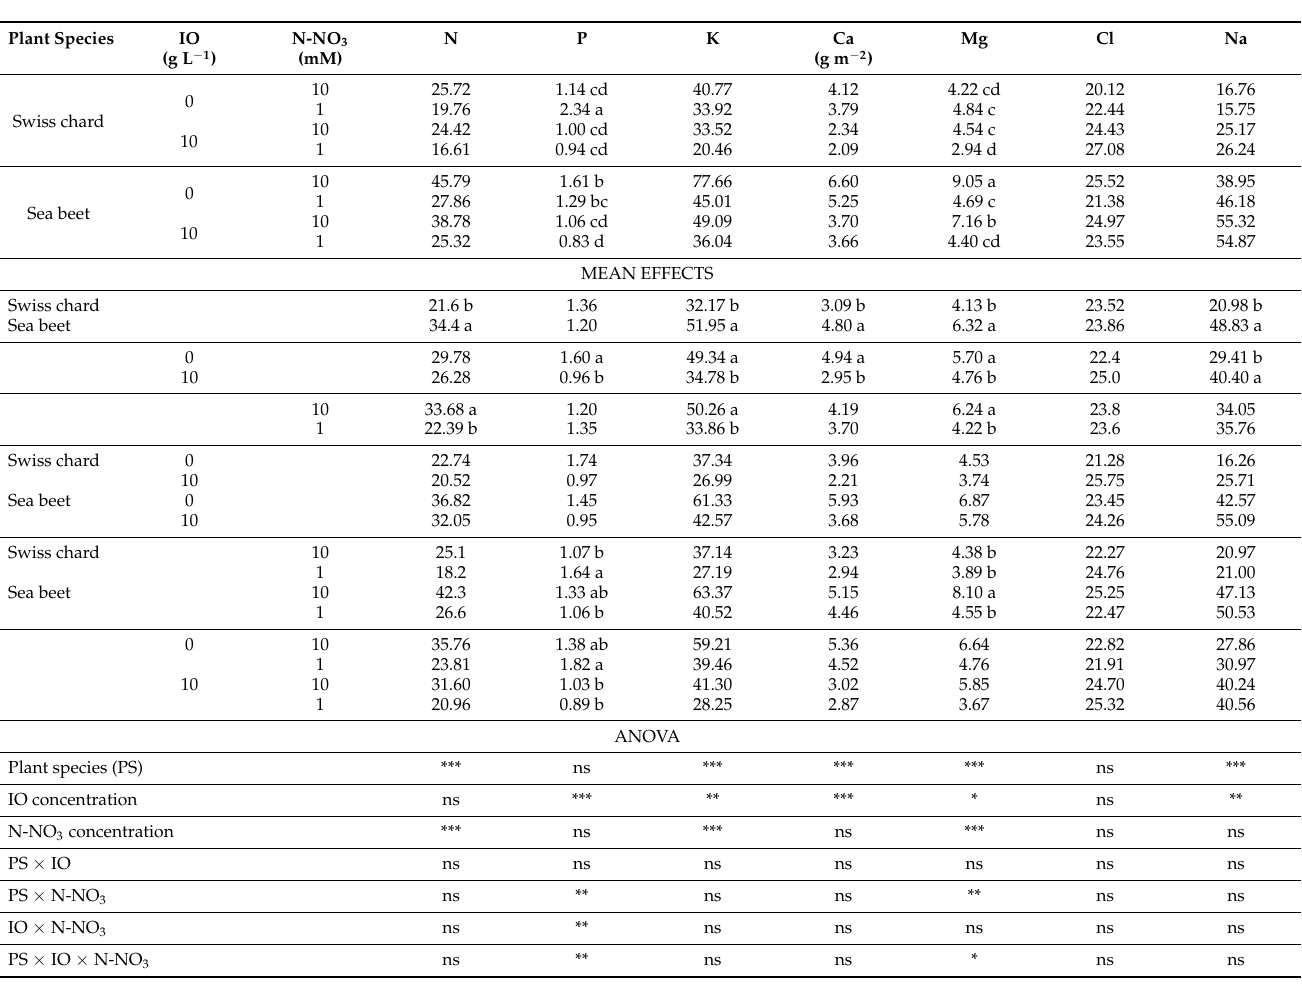
Table 4. Total uptake of nitrogen (N); phosphorus (P); potassium (K); sodium (Na); calcium (Ca); magnesium (Mg); and chloride (Cl) in Swiss chard and sea beet plants grown hydroponically with different concentrations of the sea salt Instant Ocean (IO; 0 and 10 g L − 1 ) and nitrogen (1 and 10 N-NO 3 mM) in the nutrient